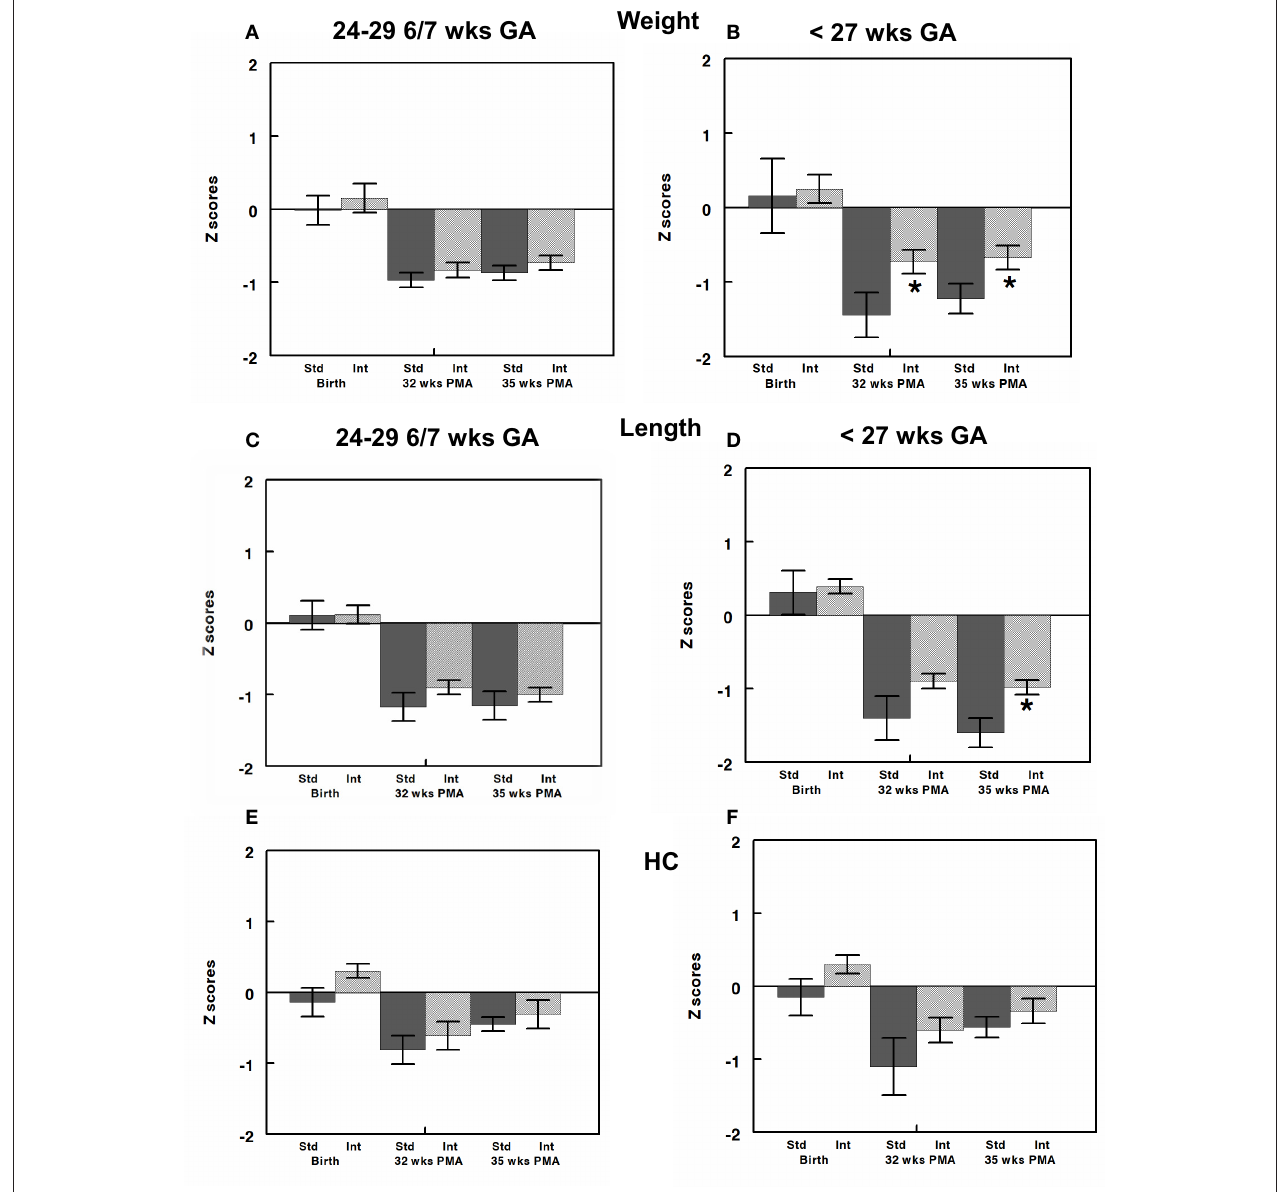
FIGURE 3 | Z-scores for weight, length, and head circumference (HC) were calculated at birth and at 32- and 35-weeks post-menstrual age (PMA) and are shown for infants born at 24–29 6/7 (A,C,E) and those born at < 27 weeks gestation (B,D,F) . All infants had similar z scores close to zero (50% on growth curve) at birth. Infants in both CG and IG exhibited some element of postnatal growth failure. However, z scores were greater in IG than CG and reached significance for weight z score at both 32 and 35 weeks and length z score at 35 weeks. All values are mean ± SEM; N , 6–30; * p < 0.05.